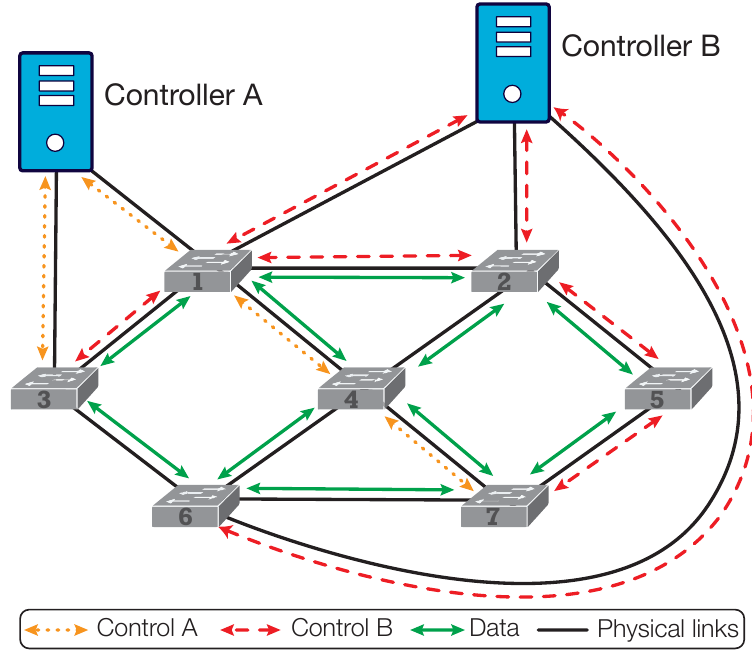
Figure 2. SDN hybrid-band control